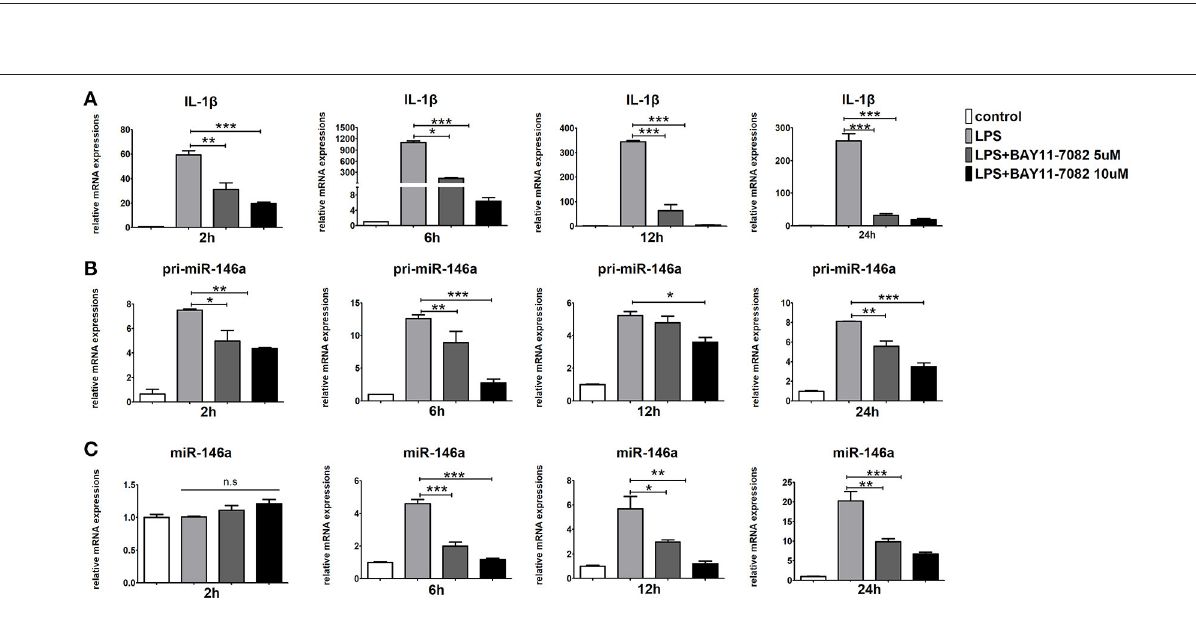
FIGURE 7 | Inhibition of NF- κ B blocks miR-146a transcription in macrophages. Raw264.7 cells were pre-treated with or without BAY11-7082 (5 µ mol/L or 10 µ mol/L) for 1h, followed by stimulation with LPS (100ng/mL). The mRNA expression levels of IL-1 β (A) , pri-miR-146a (B), and miR-146a (C) in Raw264.7 were determined by quantitative PCR at different time. Data are shown as mean ± SEM ( n = 3). * P < 0.05; ** P < 0.01; *** P <